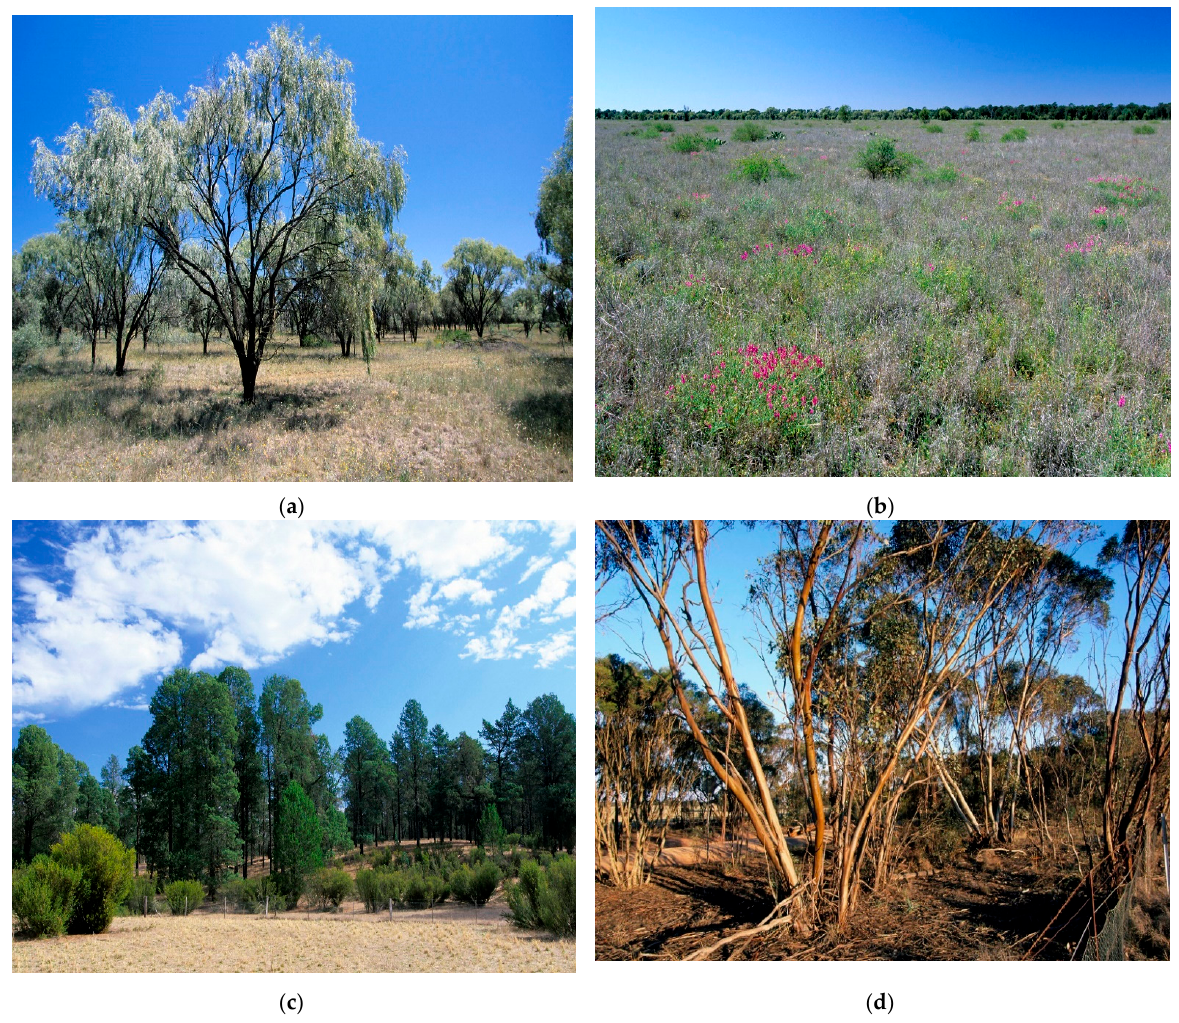
Figure 4. Four threatened inland NSW PCTs defined quantitatively in regional or local-scale floristic plot data analyses: ( a ) PCT 26 Myall ( Acacia pendula ) grassy woodland in the Riverina Bioregion, originally widespread on alluvial clay soils but mostly cleared for agriculture, listed NSW and Federal TEC. ( b ) PCT 52 Mitchell Grass ( Astrebla spp.)—Bluegrass ( Dichantheum ) grassland in the BBS and DRP bioregions, over the last 50 years most of its extent has been cultivated for crops with limit areas remaining in good condition, listed NSW and Federal TEC. ( c ) PCT 19 Murray Pine ( Callitris gracilis subsp. murrayensis ) source-bordering sand dune woodland, Riverina bioregion, original extent restricted, partly cleared for grazing and impacted by grazing by including introduced rabbits, listed NSW and Federal TEC. ( d ) Blue-leaved Mallee ( Eucalyptus polybractea ) mallee shrubland NSS bioregion, restricted extent, mainly cleared, small patches in some reserves, listed NSW TEC.